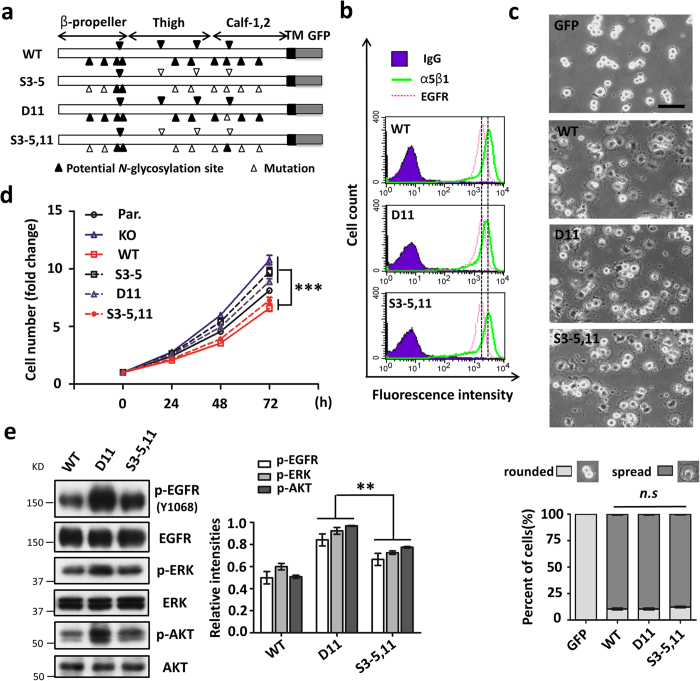
The site-11 N-glycosylation of integrin α5 plays a key role in mediating its growth-inhibitory function in HeLa cells.(a) Schematic diagram of a potential N-glycosylation mutational integrin α5 subunit (WT; S3–5; D11; and, S3–5,11). (b,c) Comparison of expression levels of α5β1 and EGFR on the cell surface (b) and cell spreading (c) among the WT; D11; and S3–5,11 cells. The stable rescued-HeLa cell lines were established as described under the “Methods” section. The expression levels of both α5β1 and EGFR on the cell surface were analyzed via flow cytometry (b). The cell-spreading abilities of these cells were analyzed, as described in Fig. 1c (n = 3 individual experiments). The percentages of rounded and spread cells were statistically analyzed (c, bottom panel, n = 9). Scale bar, 120 μm. (d) The site-11 N-glycosylation suppressed cell growth. The abilities for cell growth were compared among the parent (Par.); integrin α5-knock-out (KO); WT; S3–5; D11; and S3–5,11 HeLa cells, as described in Fig. 1d (n = 3 individual experiments). (e) The expression levels of phospho-EGFR and its downstream signaling were significantly increased in the D11, but not in the S3–5,11 cells compared with the WT. Left panel, WB pattern; right panel, quantitative analysis (n = 3 individual experiments). All values are reported as the means ± S.E. (error bars), Student’s t-test; n.s, not significant (p > 0.05); **p < 0.01; ***p < 0.001.